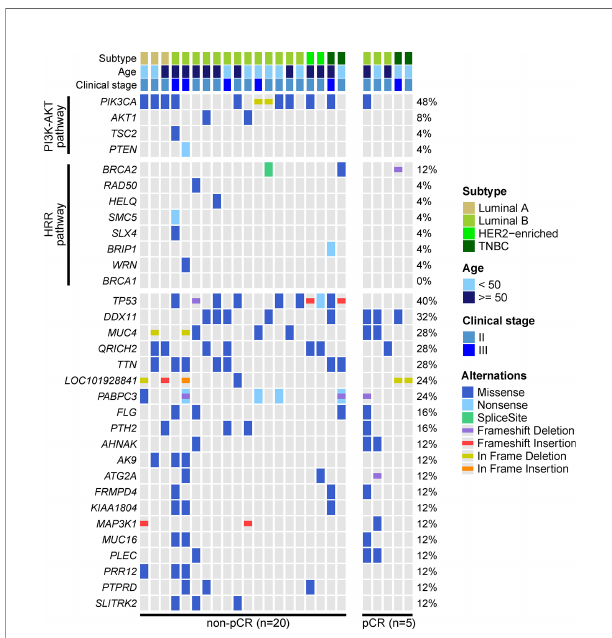
TABLE 3 | Genomic Features in Relation to Residual Cancer Burden (RCB)